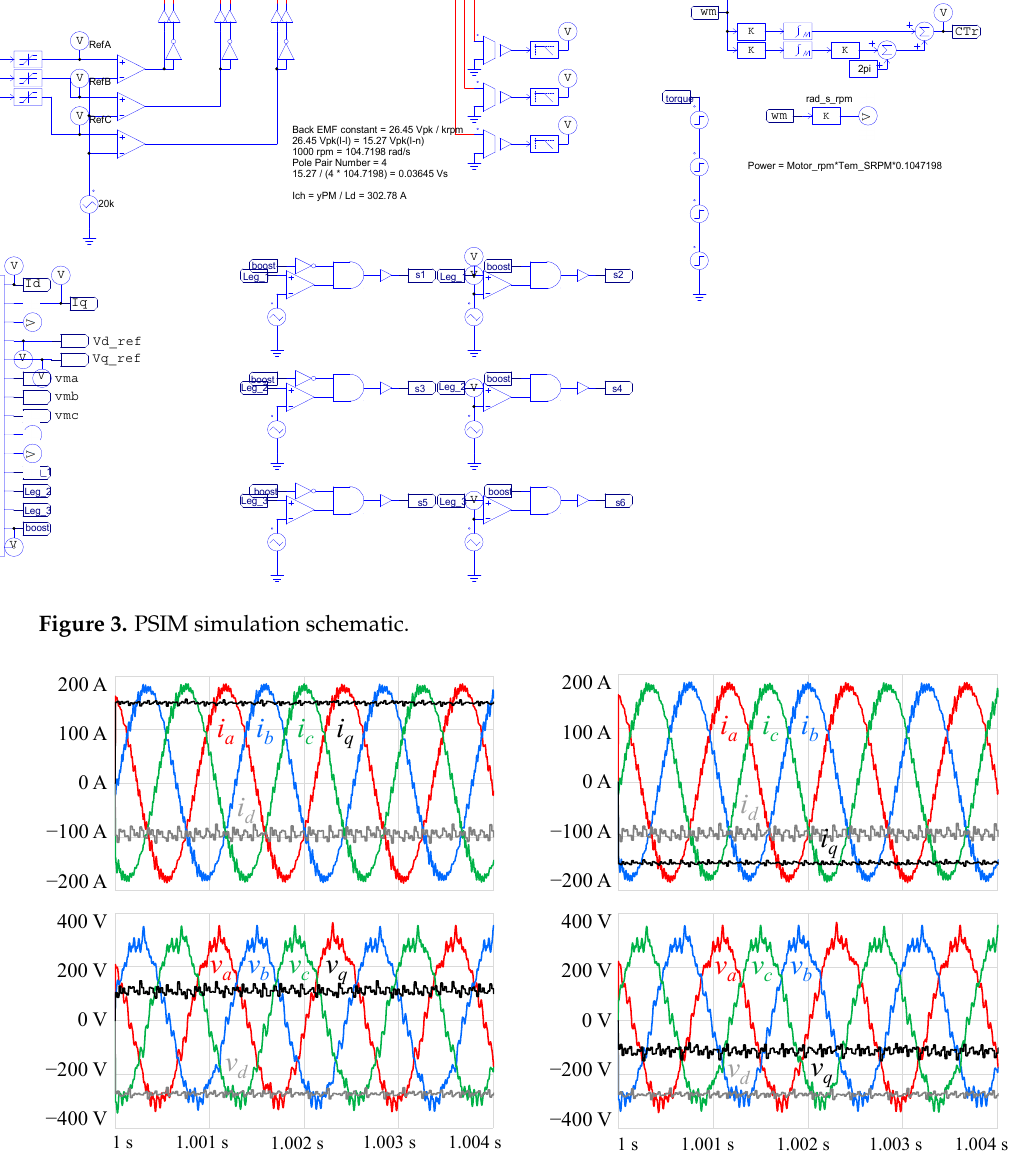
Figure 4. Simulation results of the stator winding voltages ( v a , v b , v c , v d , v q ) and currents ( i a , i b , i c , i d , i q ), applying Park’s transform with the electric machine operating as a motor at nominal speed (12